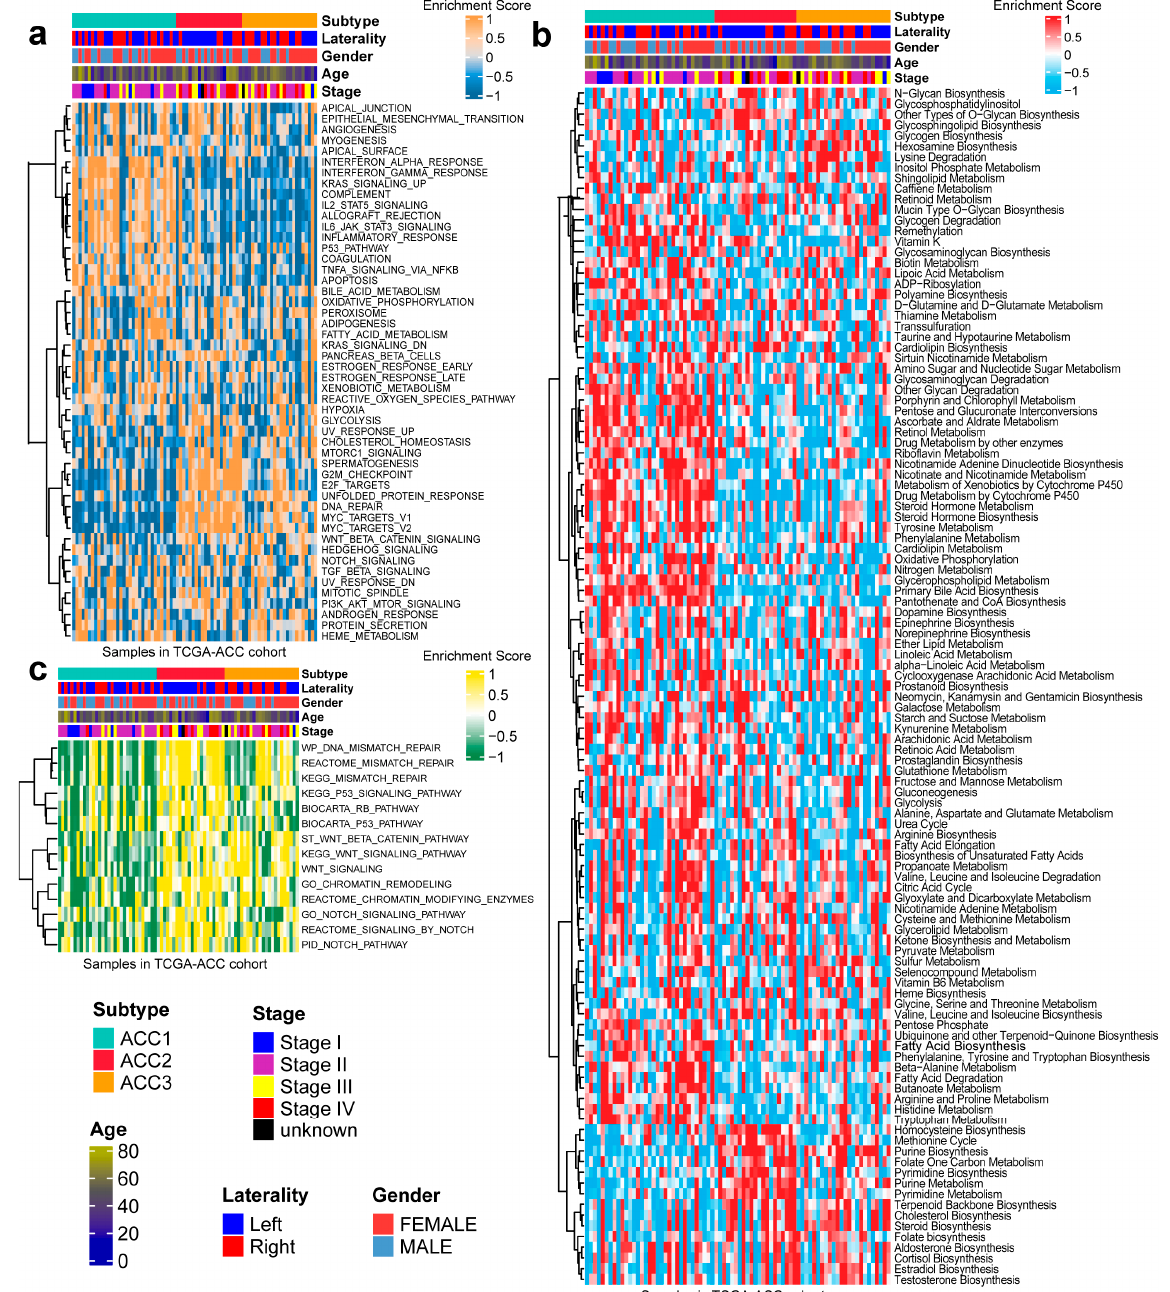
Figure 3. Differential activity of tumor-associated pathways across three ACCs subtypes in TCGA- ACC cohort. ( a ) Heatmap of 50 differentially activated HALLMARK pathways. ( b ) Heatmap of 100 pathways related to metabolism of ACCs. ( c ) Heatmap of DNA repair pathways.